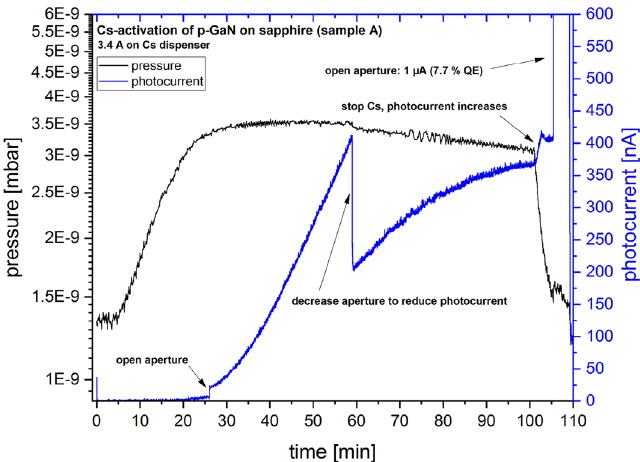
Figure 2. In-situ photocurrent (blue curve) and vacuum value (black curve, in logarithmic scale) during the Cs activation of the p-GaN surface (sample